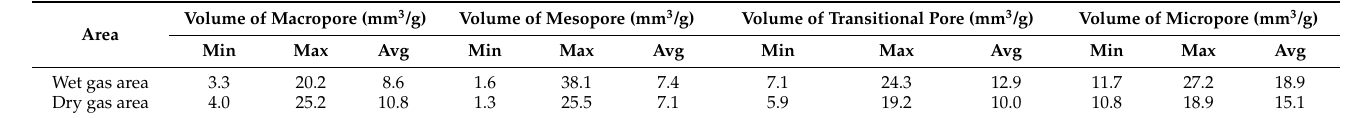
Table 2. Statistics of pore structure of coal in Enhong